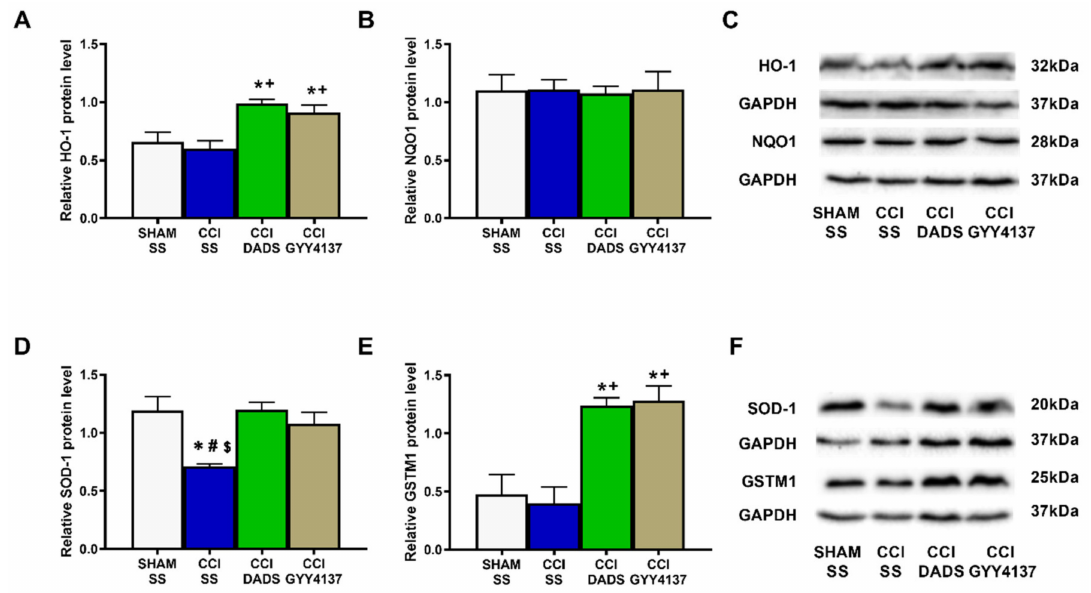
Figure 5. The influence of DADS and GYY4137 treatments on the expression of HO-1, NQO1, SOD-1, and GSTM1 in the MS of nerve-injured mice. Both treatments improved the HO-1 ( A ) and GSTM1 ( E ) levels, and normalized the downregulation of SOD-1 ( D ) induced by CCI. No alterations in the expression of NQO1 ( B ) were identified. Sham-operated (SHAM) mice treated with SS were used as control groups. All proteins are expressed relative to GAPDH levels. Blots for HO-1 and NQO1 ( C ), as well as for SOD-1 and GSTM1 ( F ), are displayed. In all pictures, * denotes significant differences vs. SHAM-animals treated with SS; + vs. CCI-mice treated with SS; # vs. CCI-mice treated with DADS; and $ vs. CCI-mice treated with GYY4137 ( p < 0.05; one-way ANOVA followed by Tukey test). Each column represents the mean, and vertical bars indicate SEM ( n = 3